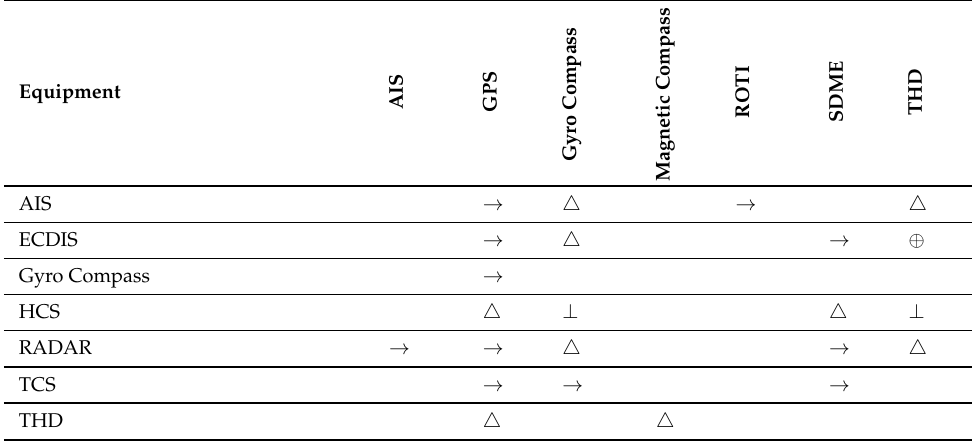
Table 3. Individual dependencies among